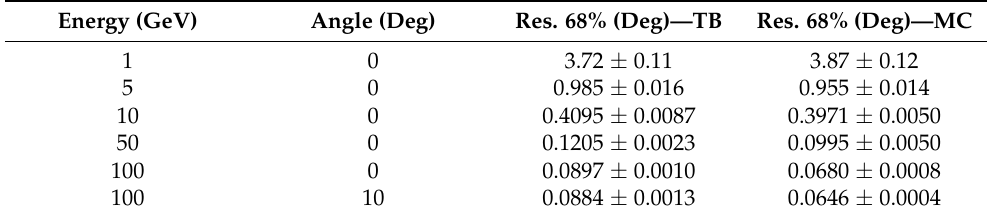
Table 1. Summary of results: XZ angular resolution from test beam (TB) and Monte Carlo (MC) data for 68% PSF (derived from [7]). Energy (GeV) Angle (Deg) Res. 68% (Deg)—TB Res. 68% (Deg)—MC 1 0 3.72 ± 0.11 3.87 ± 0.12 5 0 0.985 ± 0.016 0.955 ± 0.014 10 0 0.4095 ± 0.0087 0.3971 ± 0.0050 50 0 0.1205 ± 0.0023 0.0646 ± 0.0004